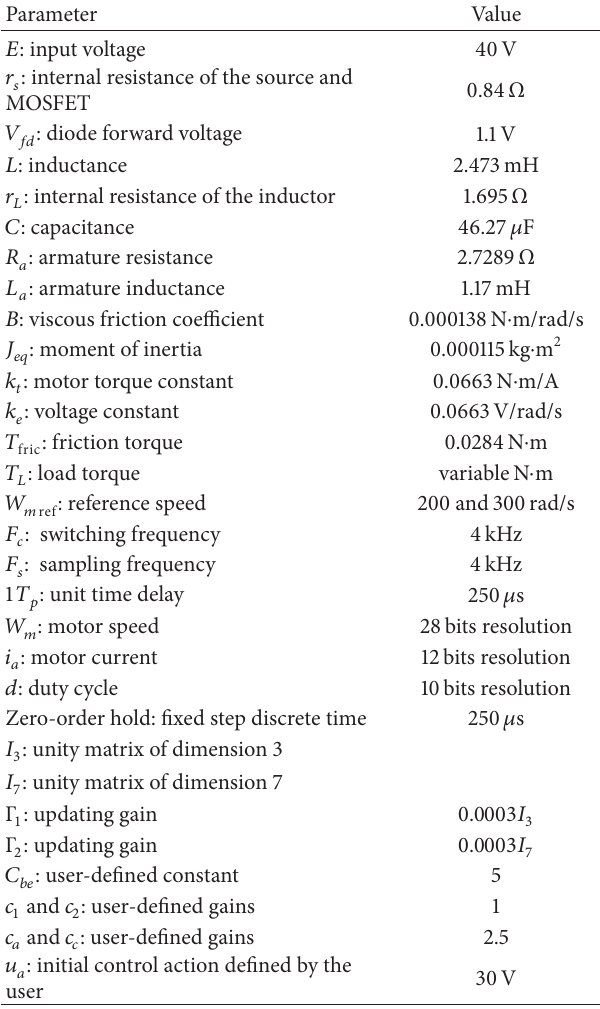
Table 1: Simulation and experimentation